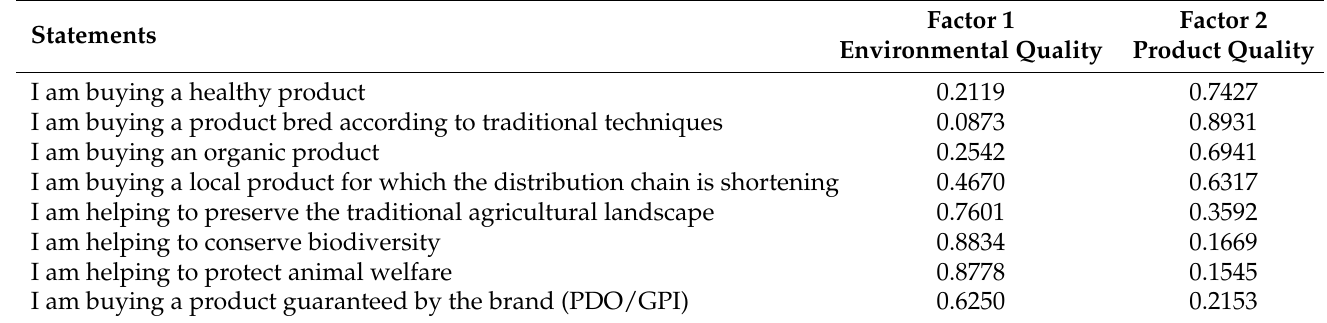
Table 2. Factor analysis of respondents’ opinions on Chianina meat: the rotated component